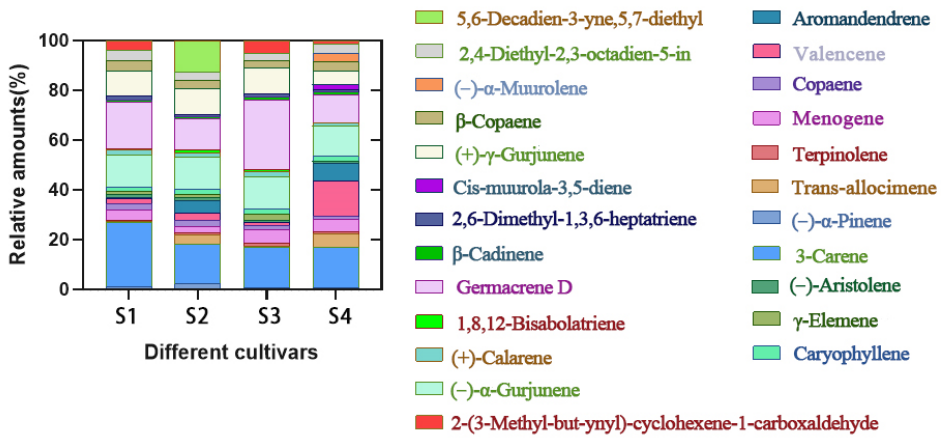
Figure 1. Floral fragrance compounds in the flowers of P. notoginseng (>1%).